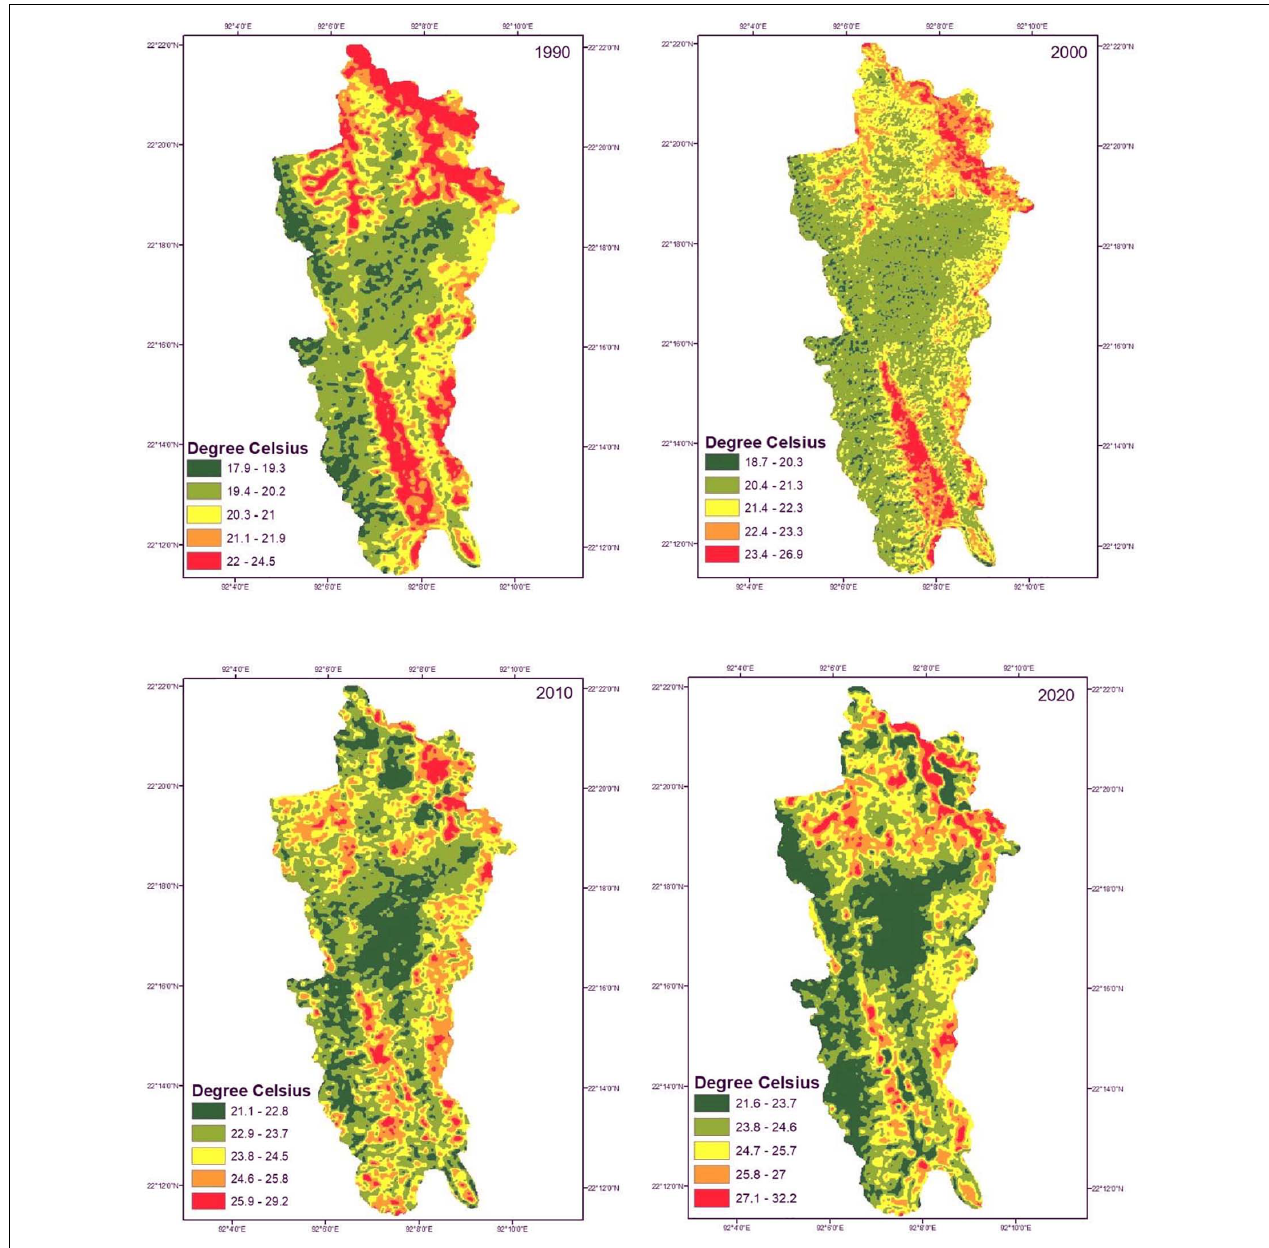
FIGURE 4 | Land Surface Temperature maps of DDWS.